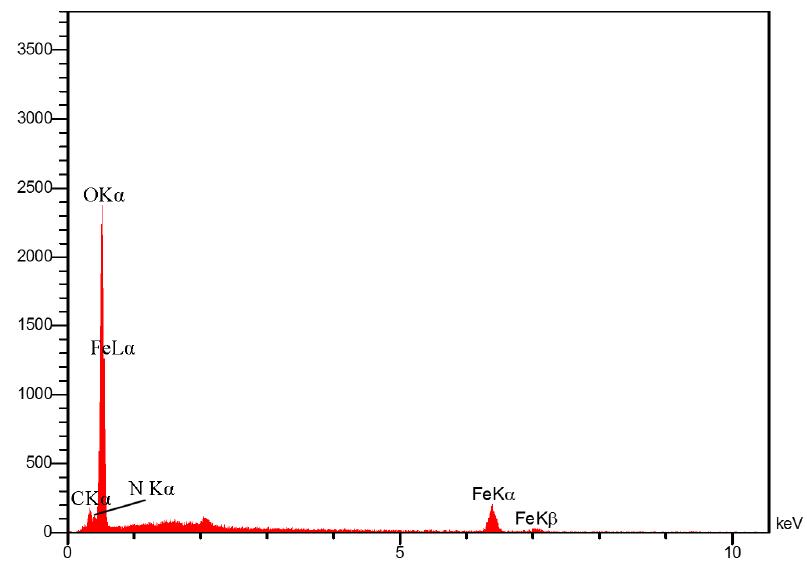
Figure 1. The energy dispersive X-ray (EDX) of SPION@CS − IL.